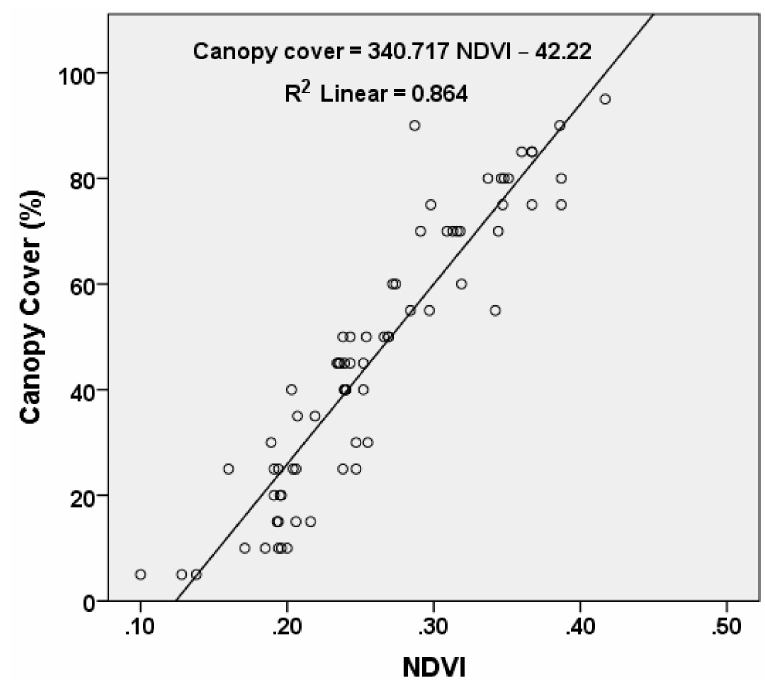
Figure 11. Linear correlation between TCC% (forest density) and NDVI.